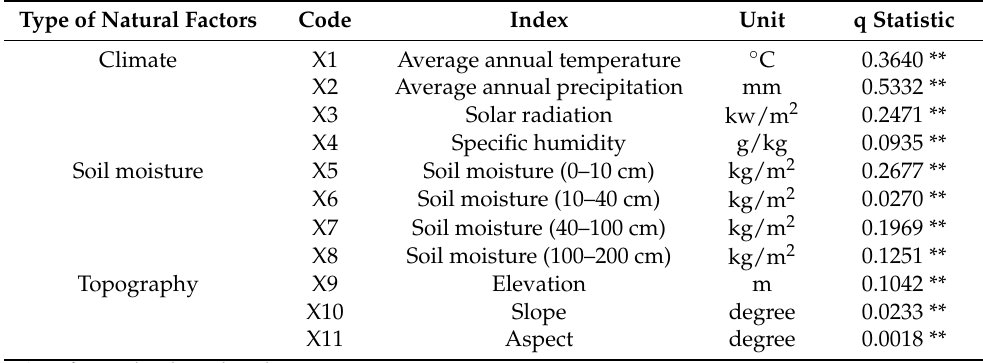
Table 2. The natural factor index for the study